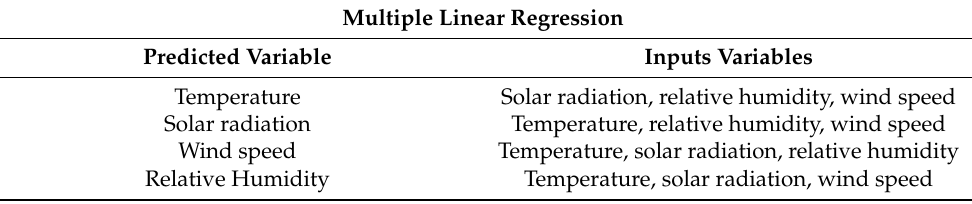
Table 1. Tuning parameters for the multiple linear regression